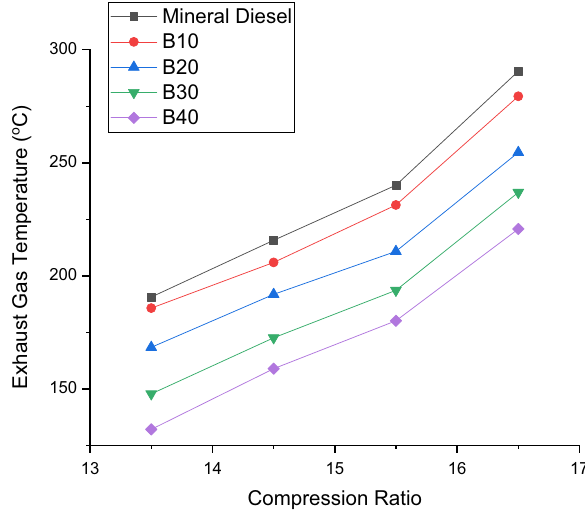
Fig. 9 Variation of EGT of dual biodiesel sample blends at different compression ratios